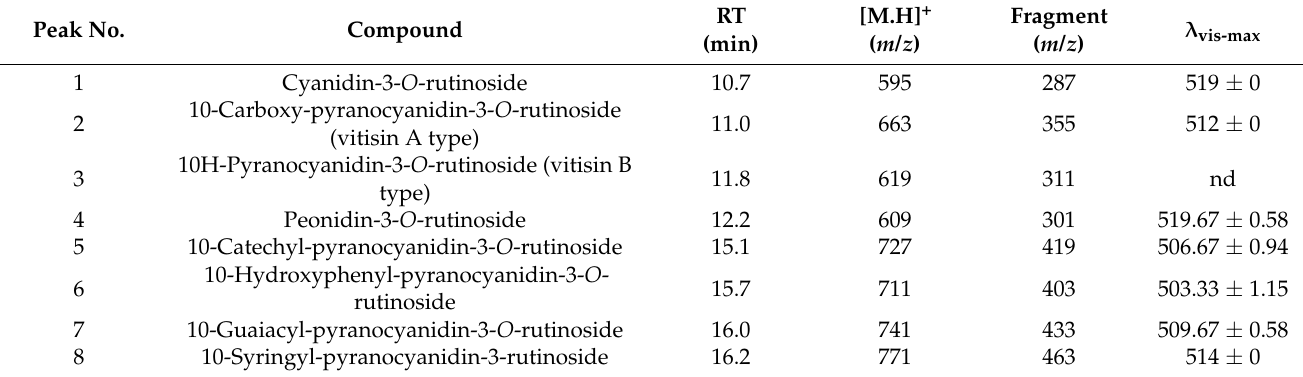
Table 2. Anthocyanins and anthocyanin-derived compounds identified in the cherry wines by UPLC-MS. Peak